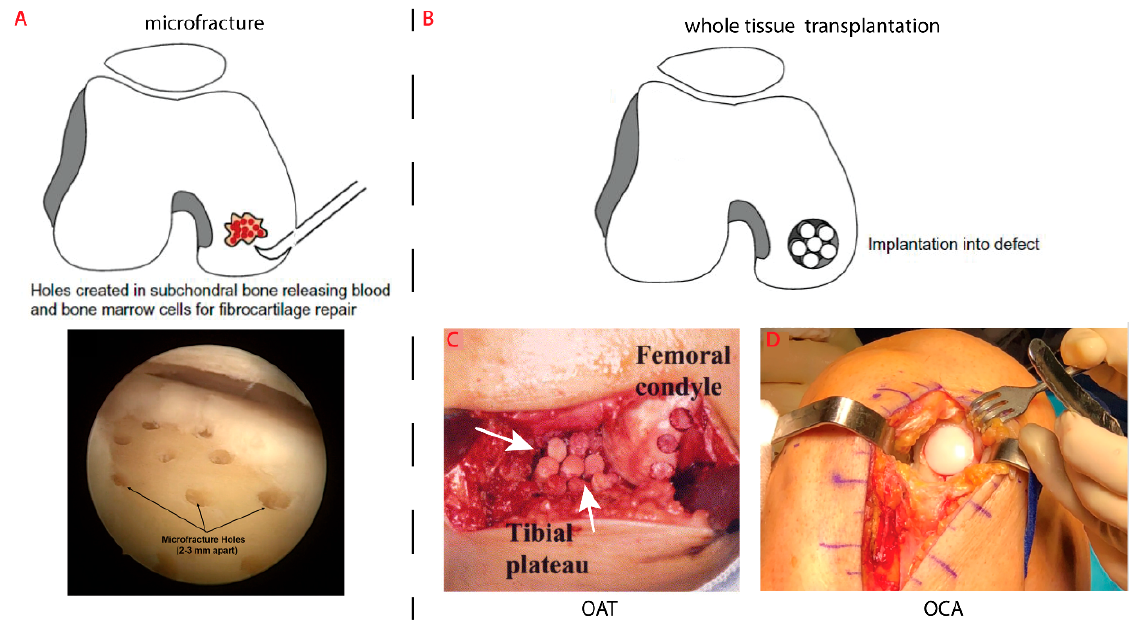
Figure 2. Current surgical techniques for the repair of an OC defect. ( A ). Microfracture [88] facilitate the repair of new tissue but primarily consists of fibrocartilage which fails to mimic the function of the native tissue [89]. ( B ). Whole tissue transplantation [88] of the mature OC unit can be from a patient (OAT) ( C ) [77] or from a donor (OCA) ( D ) [79]. The multiple plugs commonly used in OAT leaves gaps between plugs as well as between the plug and the host tissue (white arrows).